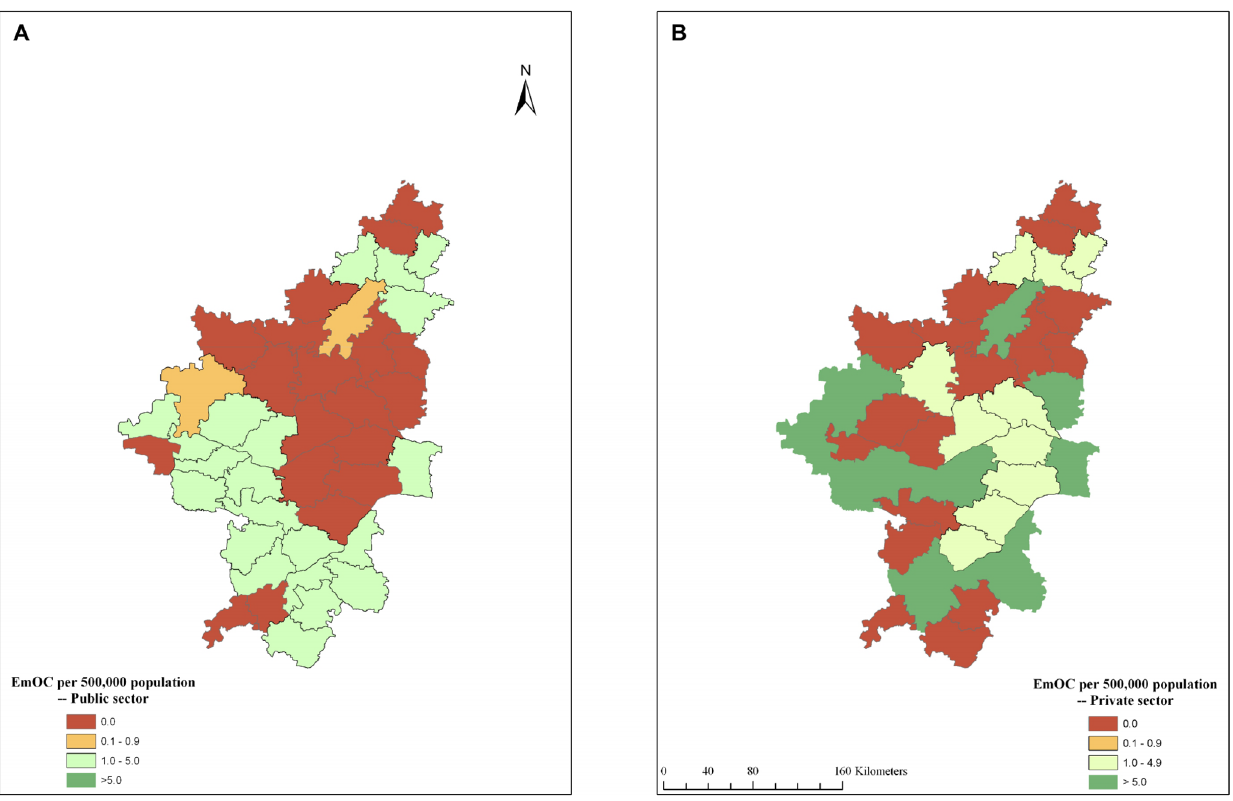
Figure 3. Geographic distribution of government and private EmOC facilities in 42 taluks of northern Karnataka, 2010. A. Government sector EmOC. B. Private sector EmOC. EmOC=Emergency Obstetric Care.